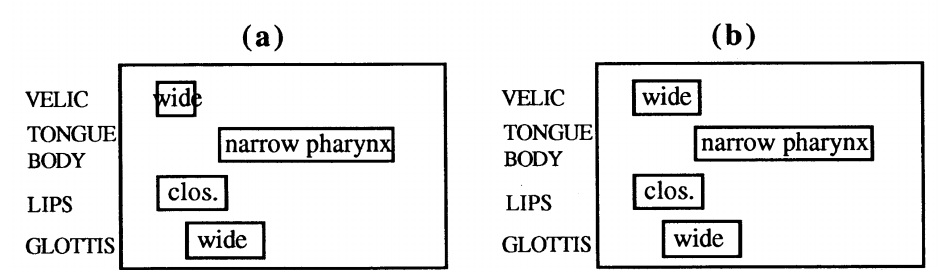
Figure 2: (a) Velar misalignment in [mph] and (b) velar alignment in [mɦ] (from Maddieson 1991, 152)